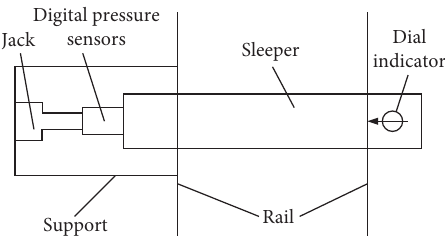
Figure 5: Schematic diagram of device for lateral resistance test.